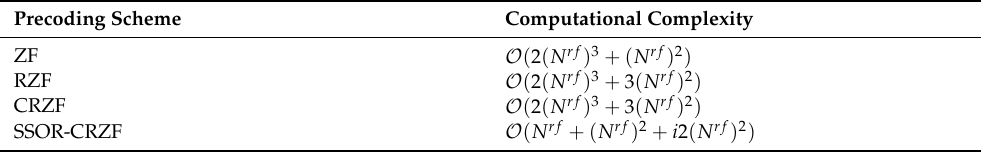
Table 3. Computational complexity comparison.